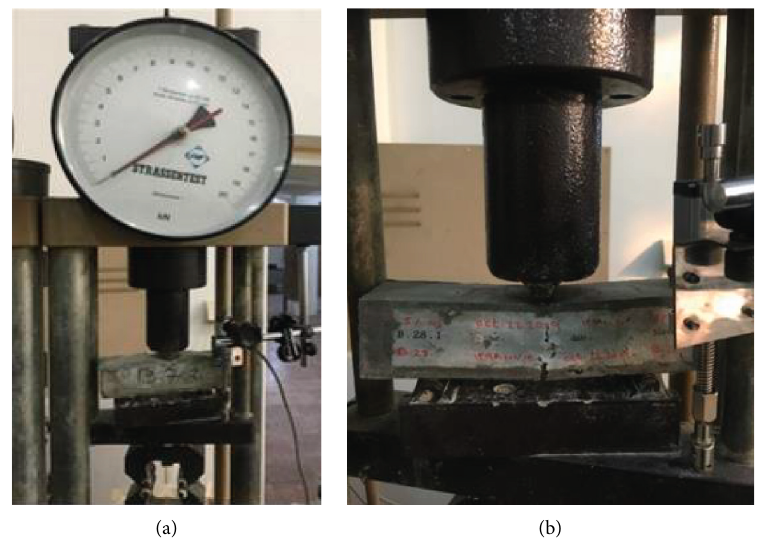
Figure 6: Flexural test: (a) test machine and (b) flexural specimen.